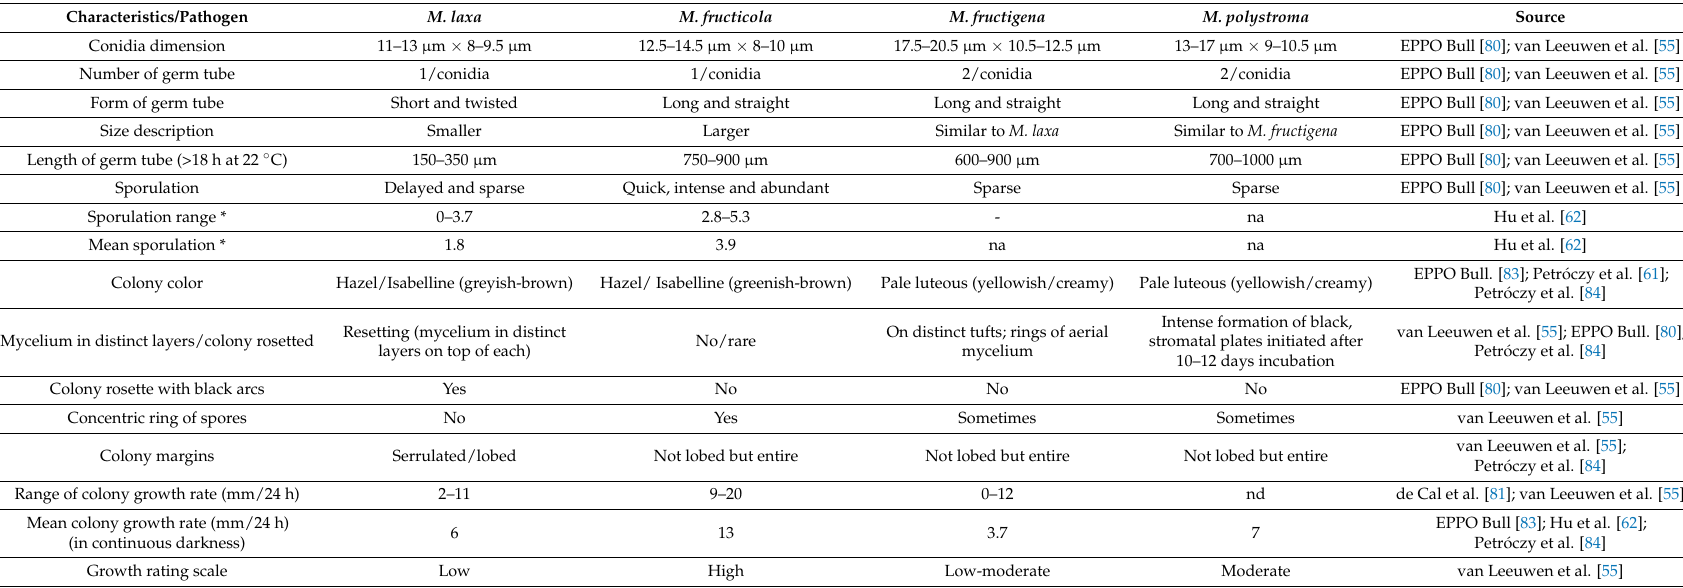
Table 2. Main differences in culture between Monilinia laxa and the other three associated EU-28 Monilinia